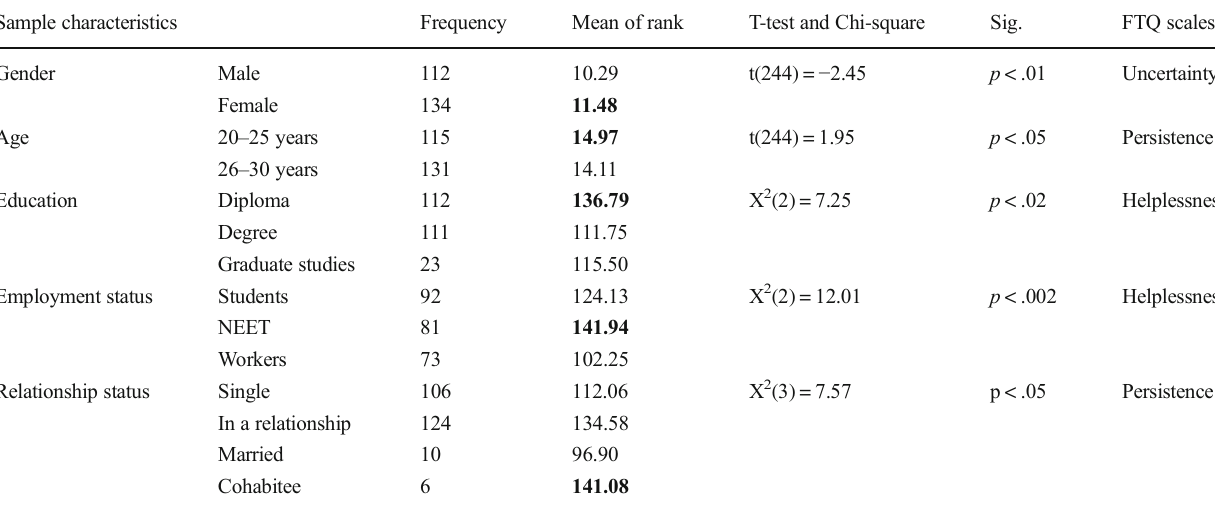
Differences in the Future Thinking Questionnaire subscales based on independent variables Sample characteristics